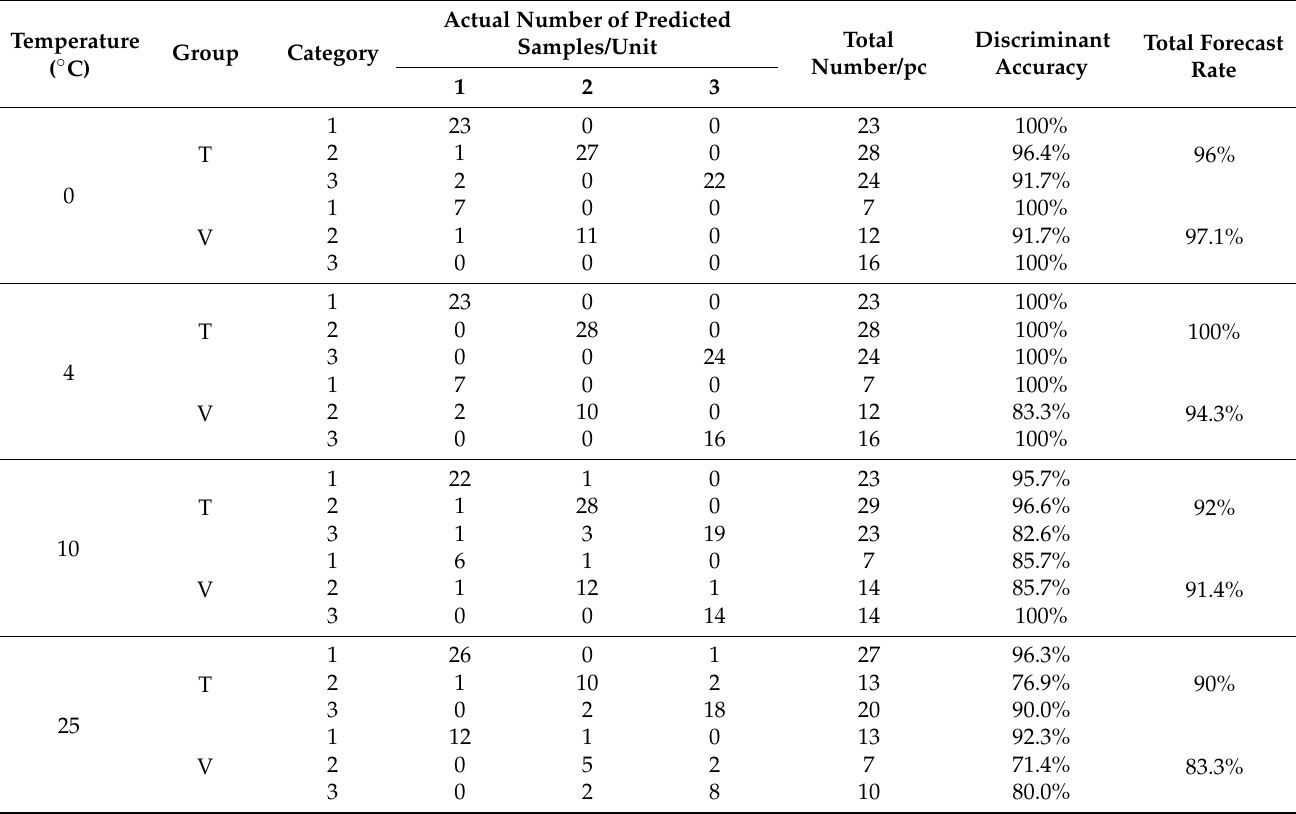
Table 4. Results of Fisher’s discriminant function for freshness of cherry